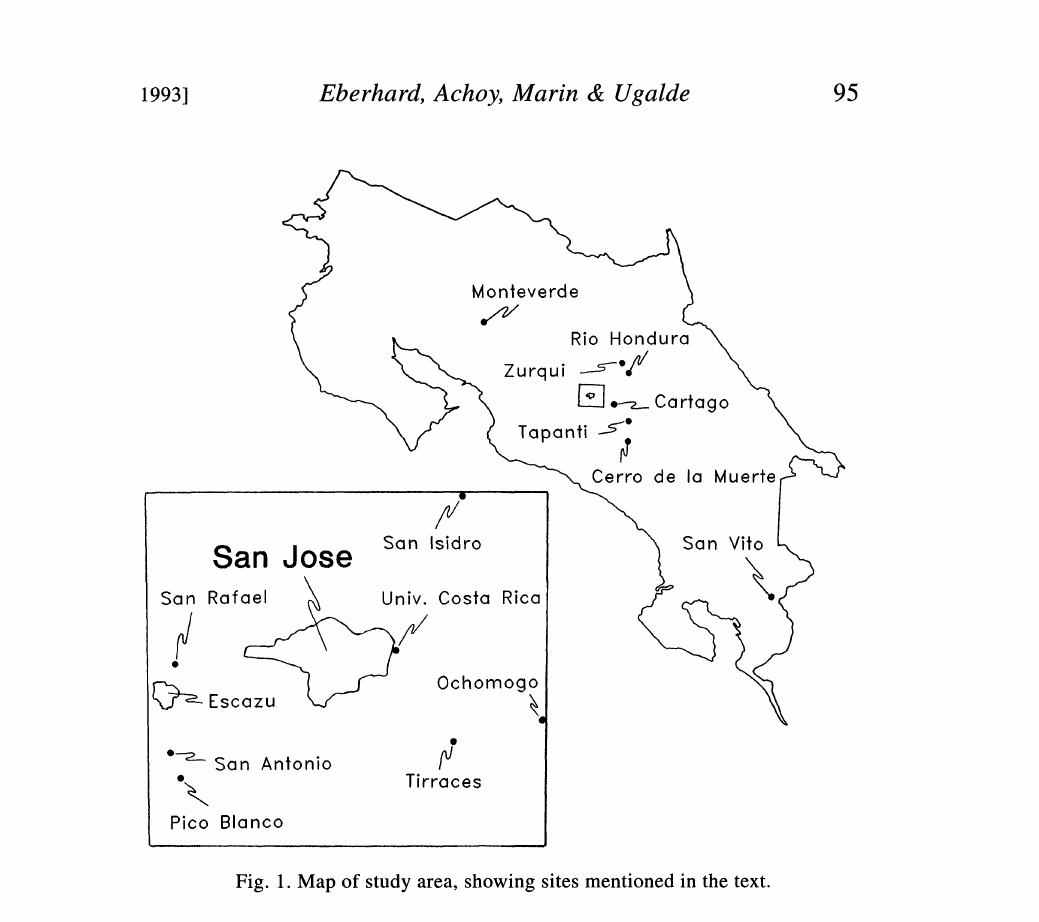
Fig. 1. Map of study area, showing sites mentioned in the